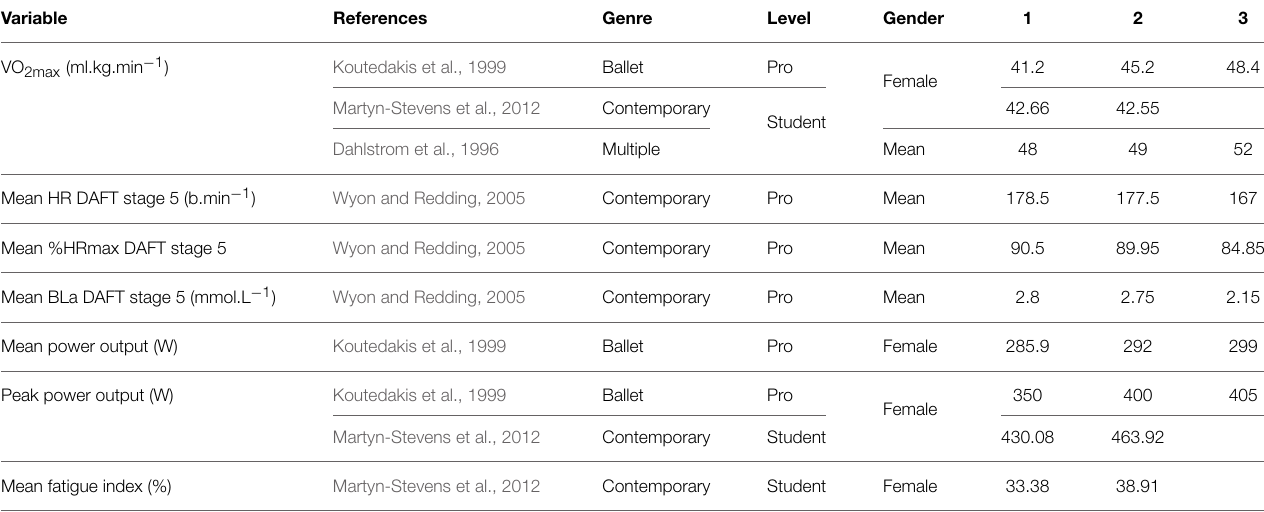
TABLE 5 | Mean data of studies examining measures of cardiorespiratory fitness pre-, (mid-), and post- a schedule of dance training and/or performance without intervention. Variable